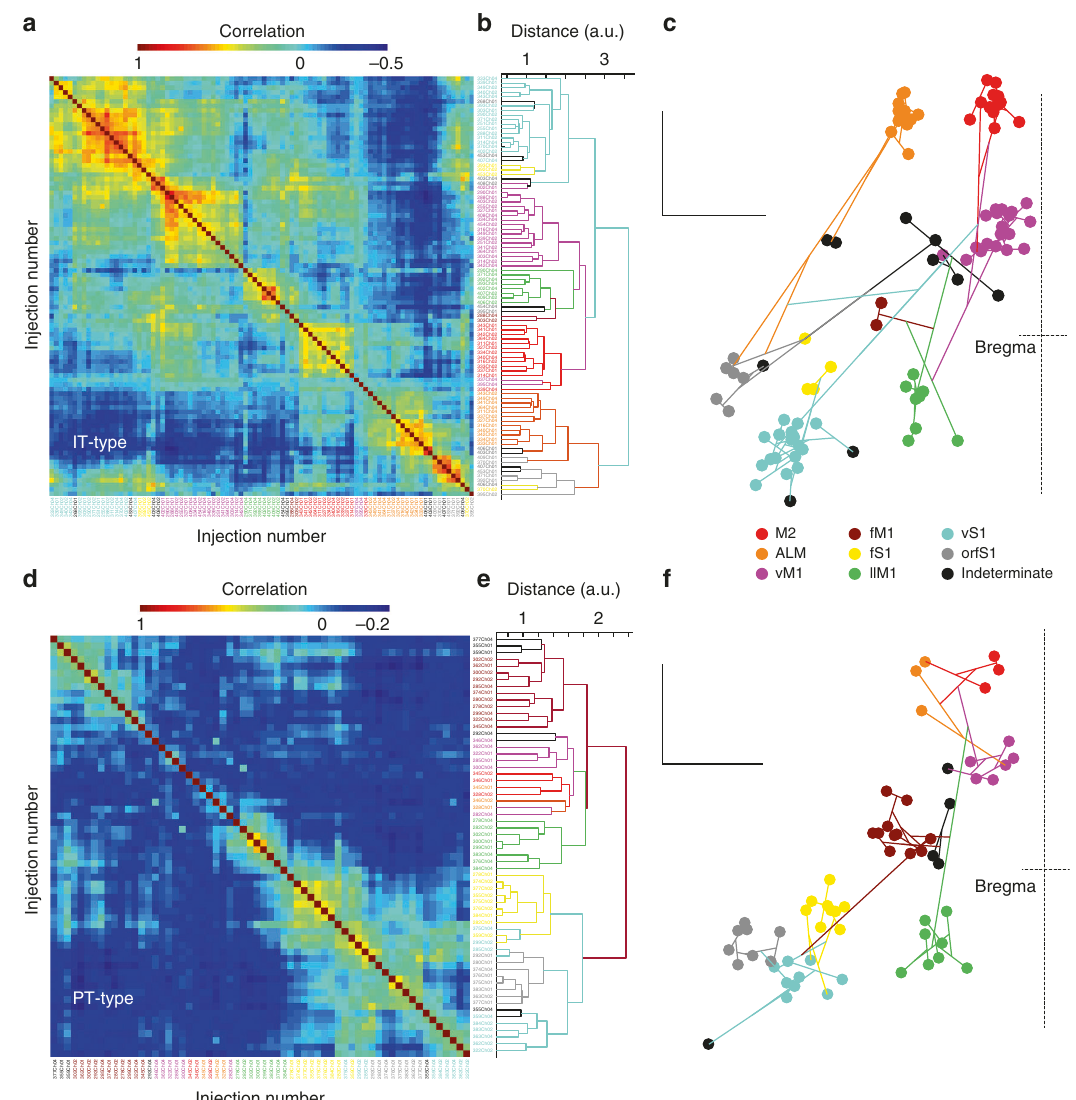
Fig. 8 Hierarchical clustering of IT-type and PT-type corticostriatal projections. a Pairwise correlation scores for all IT-type projections studied compared for ipsilateral striatal voxels ( N = 92). Colormap shows high correlation in red and negative correlation in blue. Perfect correlation is along the main diagonal due to comparing an individual case to itself. b Each injection case was then hierarchically clustered using differences in the correlation score as the distance measure. Individual injection cases are shows as the free endings of the dendrogram at left and are color coded according to the injection site location cluster to which they were assigned. c Using a dorsal view of the brain (with bregma marked at right; scale, 1 mm), the dendrogram from b was plotted using the injection site location as the point for the free ending of the tree. Injection site locations displayed as in Fig. 1k. d – f Pairwise correlation scores and dendrograms for all PT-type projections studied ( N = 62), plotted as for IT-type